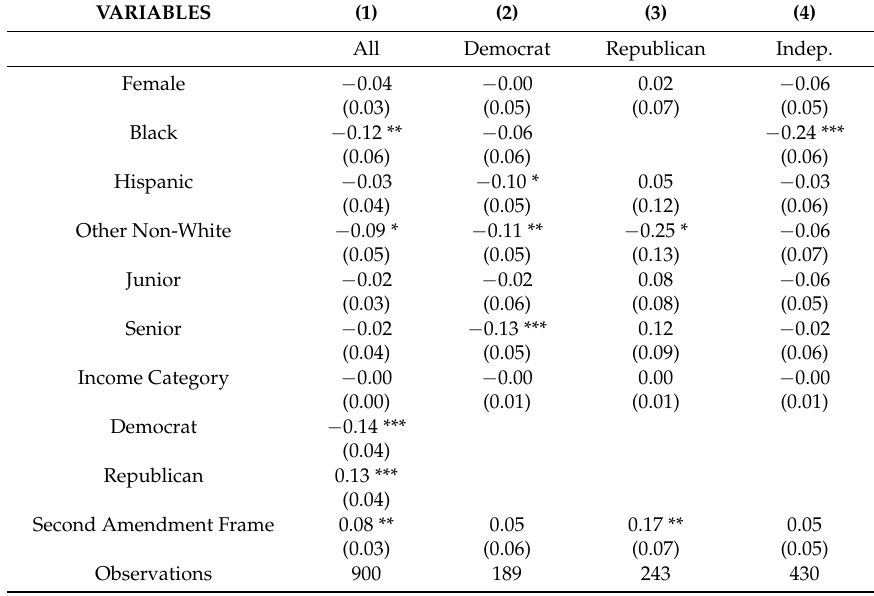
Table 7. Framing effects and attitudes towards gun ownership rights. Probits: dependent variable equals one if strongly agree with the statement that “it is important for Americans to have the right to arm themselves with